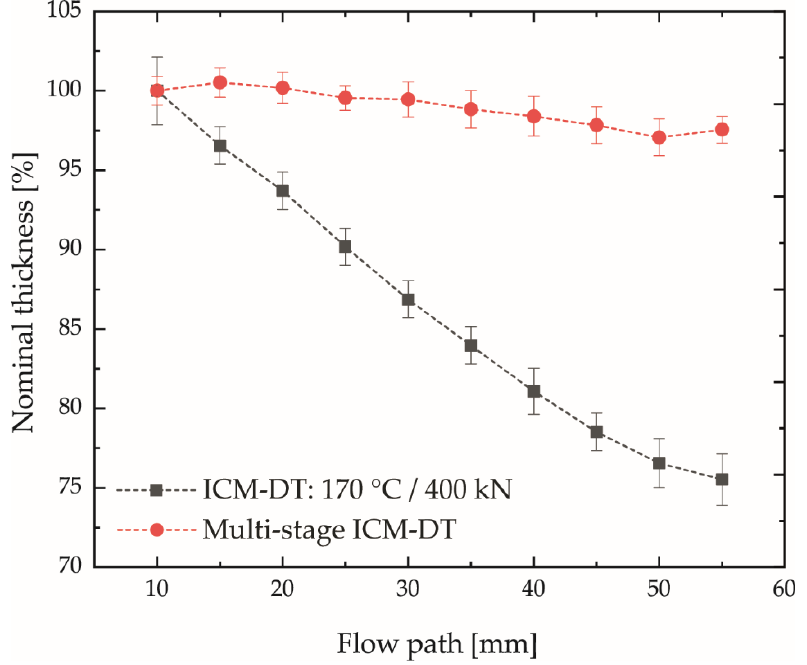
Figure 11. Achieved thickness dimensional stability of the multistage ICM-DT (see Figure 2b/Table 3) process compared to the single-stage process with maximum compression force and maximum mold temperature.